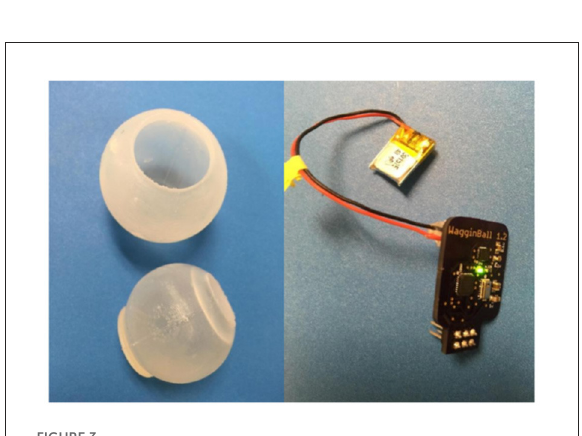
FIGURE3 Ball sensor. left: outer ball and inner ball; right: electronics and battery that are placed inside the inner